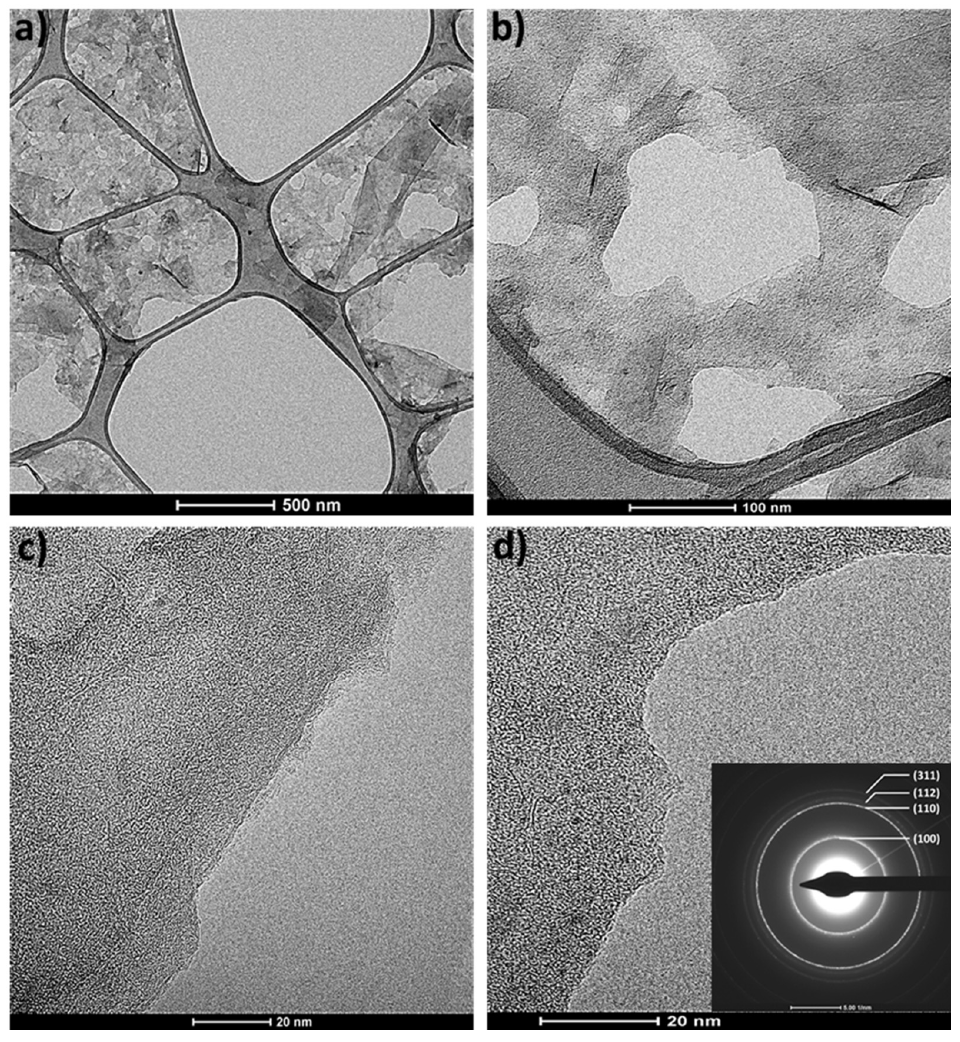
Figure 5. HR-TEM images of EXG 3000 120 min. The pronounced nature of the damage caused by prolonged sonication of the starting EXG 3000 sample is seen in these images with ( a , b ) the generation of holes in the basal planes of the nano-sheets, ( c ) a more extensive exfoliation and ( d ) a rugged morphology at the edges.